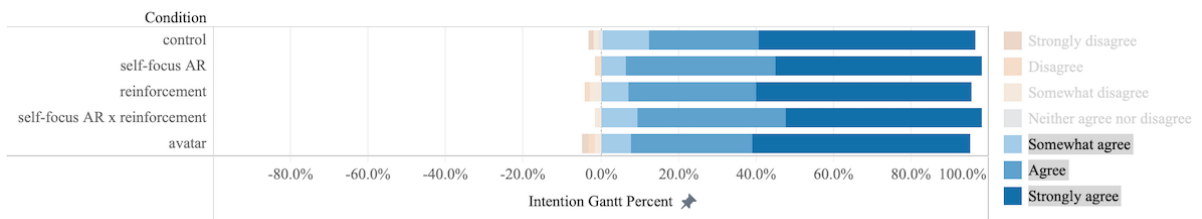
Figure 9. Responses for behavioral intention. Responses are strongly skewed toward higher levels of agreement for all conditions, indicating a ceiling effect. AR: augmented reality.